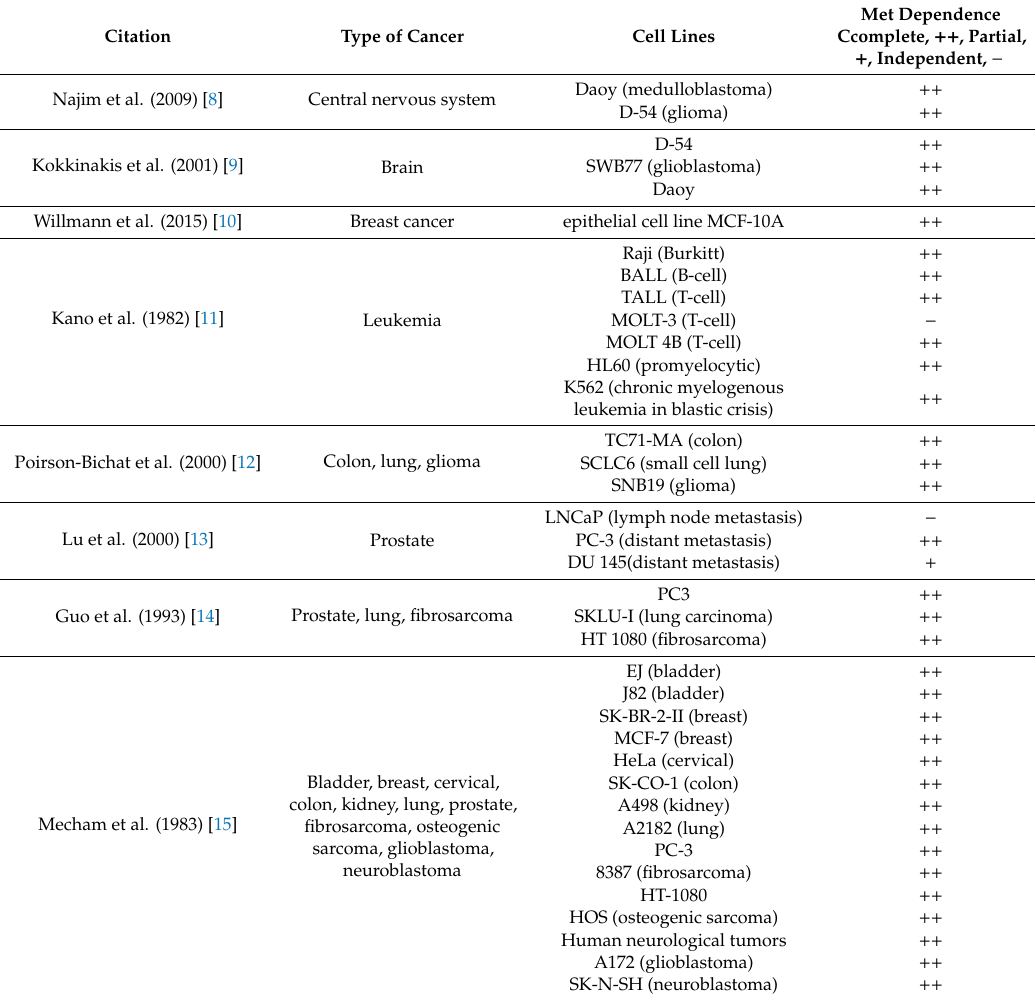
Table 1. Observed methionine dependence of various cancer cell